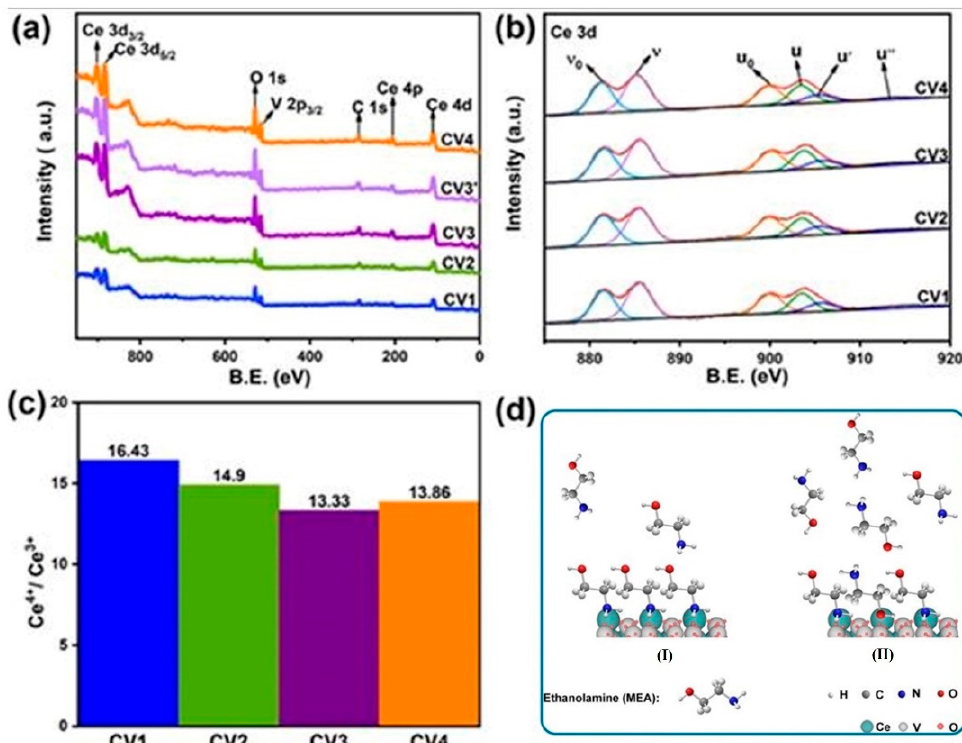
Figure 6. ( a ) XPS spectra of the as-prepared samples, ( b ) Ce 3d and ( c ) Ce 4+ /Ce 3+ ratio, ( d ) Possible interaction between MEA and Ce (I) process of protect Ce 3+ in lowly ethanolamine concentration (II) process of oxidize Ce 3+ in highly ethanolamine concentration.